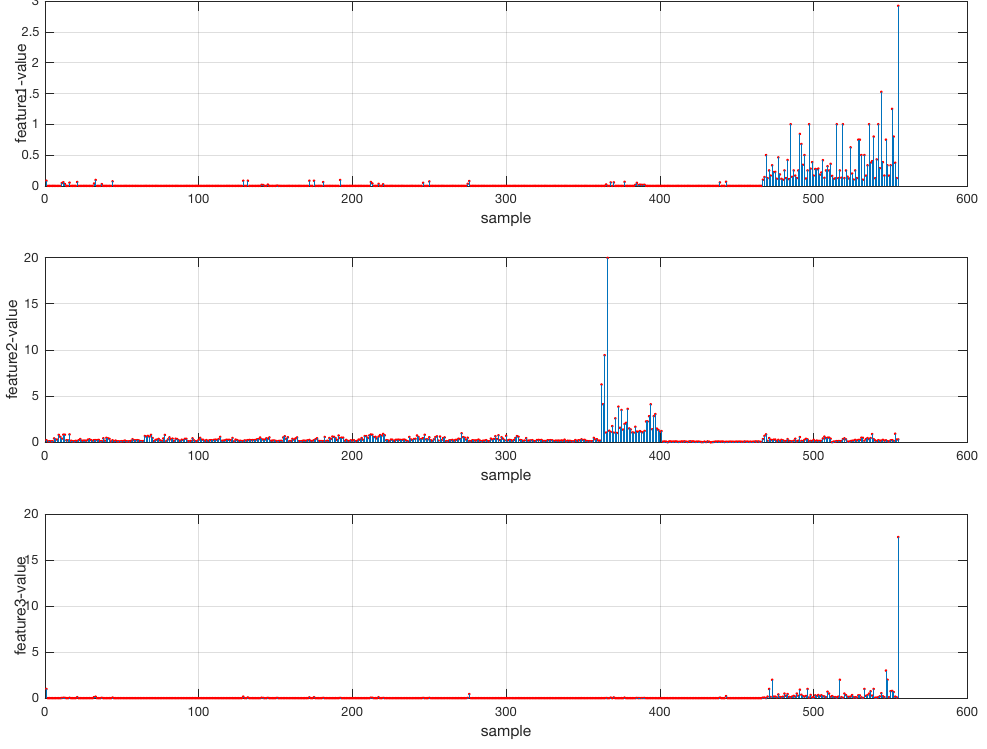
Figure 4. The distribution features of dissolved gas analysis (DGA) dataset in our study.